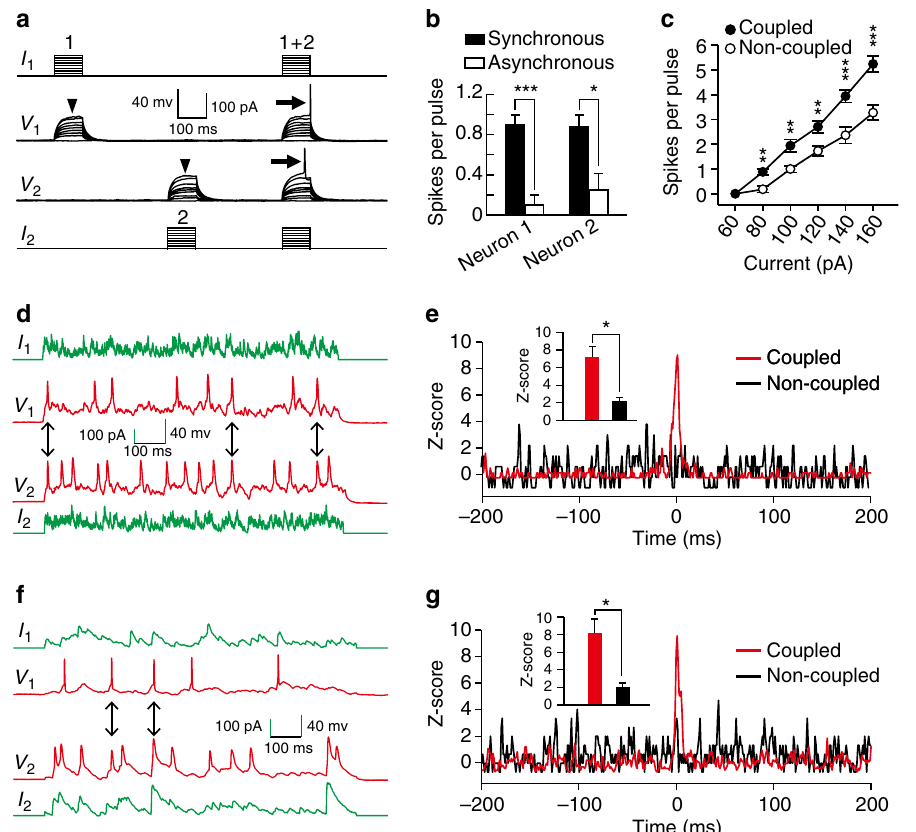
Figure 10 | Electrical coupling promotes AP generation and synchronous firing of layer 1 interneurons. ( a ) Sample traces of synchronous (1 þ 2) or asynchronous (1 or 2) injection of subthreshold current pulses into electrically coupled interneurons in neocortical layer 1. Note that synchronous injection, but not asynchronous injection (arrowheads), results in AP generation (arrows). ( b ) Summary of the firing rate of the two interneurons shown in a responding to 80pA current injection. ( c ) Summary of the firing rate in electrically coupled or non-coupled interneurons responding to simultaneous current injections. ( d – g ) Electrical coupling promoting synchronous firing of electrically coupled neurons in neocortical layer 1 in response to uncorrelated simulated neuronal activity ( d , e ) or uncorrelated native neuronal activity ( f , g ). ( d , f ) Sample traces of voltage changes in electrically coupled interneurons. Arrows indicate the spikes that occur in both neurons within a 1ms window. ( e , g ) Normalized cross-correlogram ( Z -score) analysis. The bin size is 1ms. Note that the firing frequency is significantly increased near 0ms for coupled interneuron pairs (red) but not for non-coupled interneuron pairs (black), indicating synchronous firing. The insets show the statistical analysis of Z -scores of coupled/non-coupled interneuron pairs. * P o 0.05, ** P o 0.01, *** P o 0.001. Mann–Whitney rank sum test and two-tailed paired t -test. Error bars represent mean ±